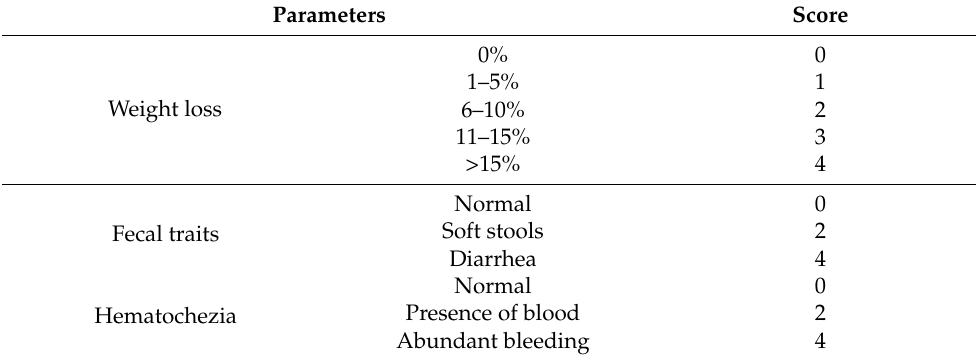
Table 3. The specific scoring rules of the disease activity index (DAI). Parameters Score